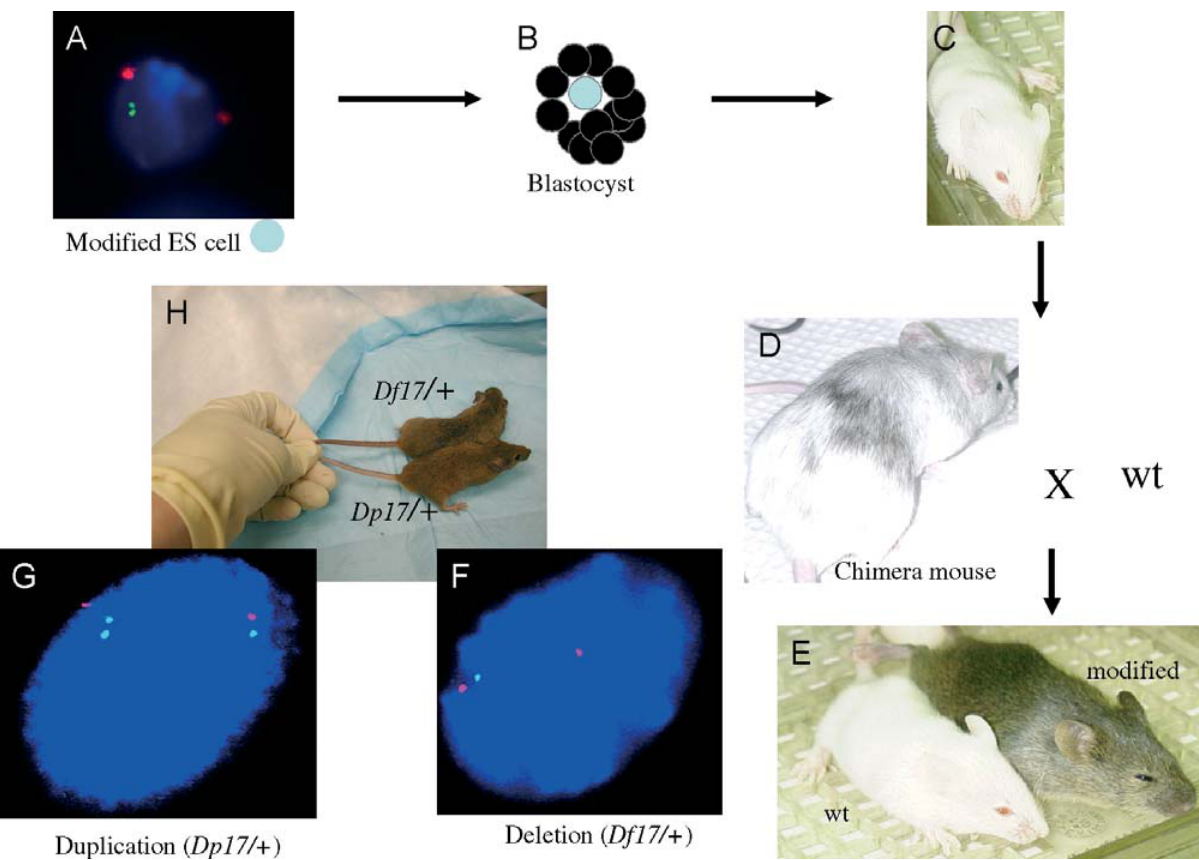
Figure 3 - Schematic representation of the generation of mice carrying genomic rearrangements. ES cells that were first modified with the target of loxP sites and Cre recombinase transient expression in order to obtain the desired rearrangement are analyzed. Mini Southern analysis and FISH (in this exam- ple a BAC containing the PMP 22 gene that is outside the region to be modified was labeled in red, and a BAC containing the Srebp 1 gene, inside the rear- ranged region, was labeled with green) (A) are done in order to identify the engineered chromosomes. Once the ES cells carrying the modification are identified they are injected into a wild type embryo in the blastocyst stage (B), and these are implanted in a foster mother (C). Chimeric mice are born, whichwillhavedifferentpercentagesofchimerism,andareingeneralrecognizablebypatchesofdifferentcoatcolor.Eachchimericmousewillbemated withawildtypemouse(D);theirprogenywillincludewildtypeanimalsandothersderivedfromtheinitialEScell(E),someofwhichwillbecarryingthe modification.InthisspecificcasealltheanimalsderivedfromthemodifiedEScellwillbemodifiedduetothefactthattherewererearrangementsinboth chromosomes (a deletion in one and the reciprocal duplication in the other). FISH on tail fibroblasts can be used to confirm the genotypes (F-G). Also these specific mice could be distinguished between each other by coat color